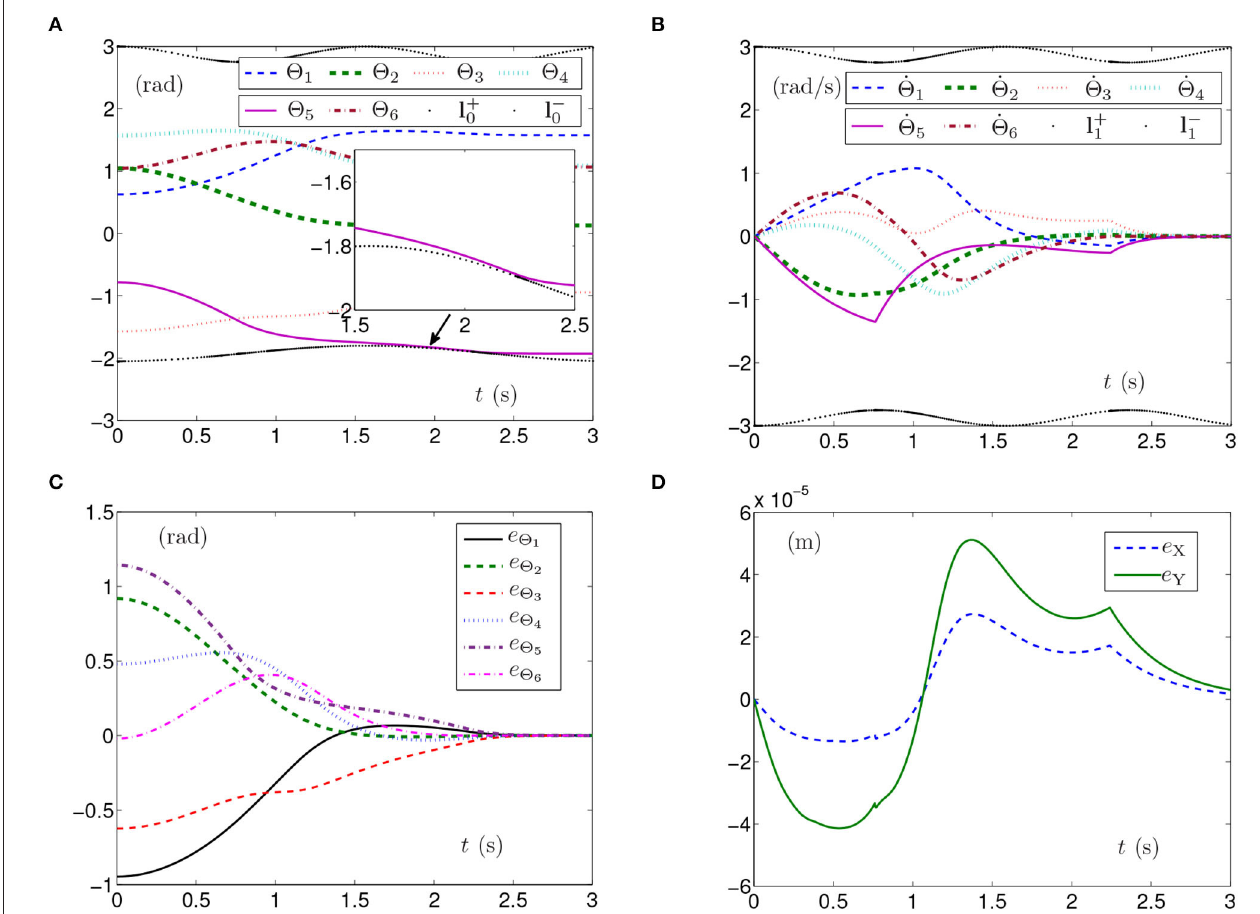
FIGURE 6 | Synthesized results of the planar manipulator using SMCSvZ with time-varying physical limits verged in case B. (A) Profiles of joint angles. (B) Profiles of joint-angle velocities. (C) Profiles of joint-angle errors. (D) Profiles of end-effector position